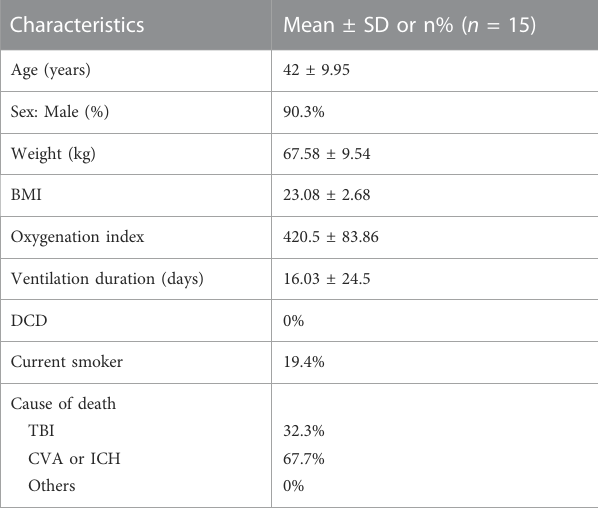
TABLE 1 Donor characteristics.